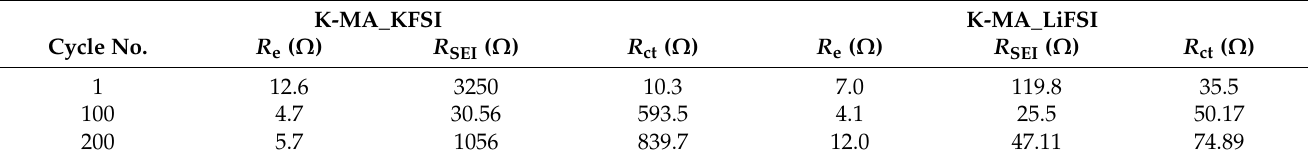
Figure 6. SEM images of ( a ) pure K − MA, ( b ) pristine K − MA, ( c ) K-MA_LiFSI and ( d ) K − MA_KFSI after completing 200 cycles.